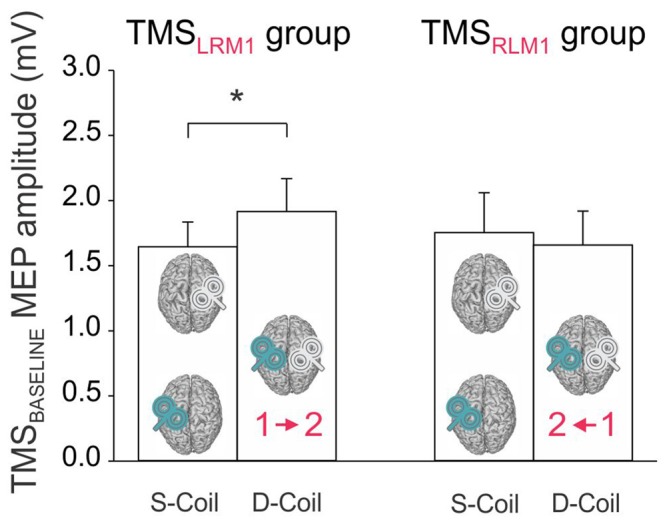
Amplitude of MEPs (mV) recorded at TMSBASELINE in the Single-Coil (S-Coil) and Double-Coil (D-Coil) blocks in the TMSLRM1 group (on the left; group receiving the left M1 pulse first in the D-Coil blocks) and in the TMSRLM1 group (on the right; group receiving the right M1 pulse first in the D-Coil blocks). Data from MEPLeft and MEPRight are pooled together. *Significantly different (p < 0.05).